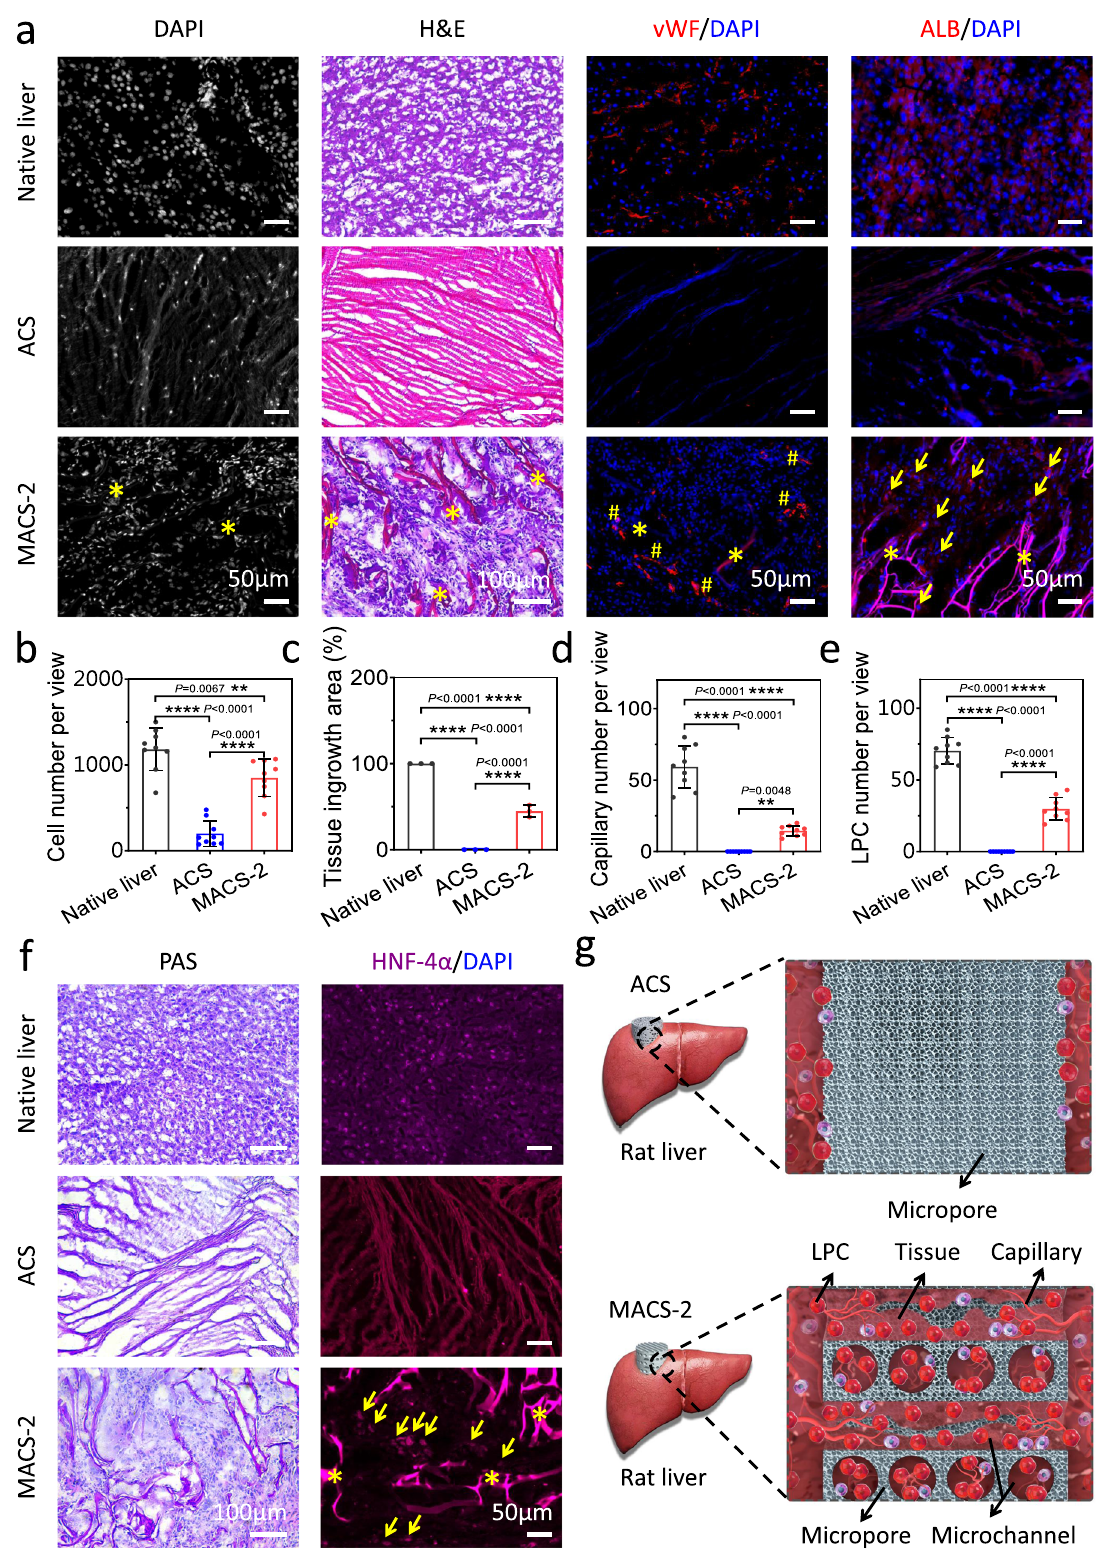
enabled full contact between bacteria and the MACS-2. The grafted hydrophobic alkyl chains could insert into the lipid bilayer of the bacterial outer membrane and cause bacterial membrane damage, leading to the leakage of intracellular materials 24,26,38 .